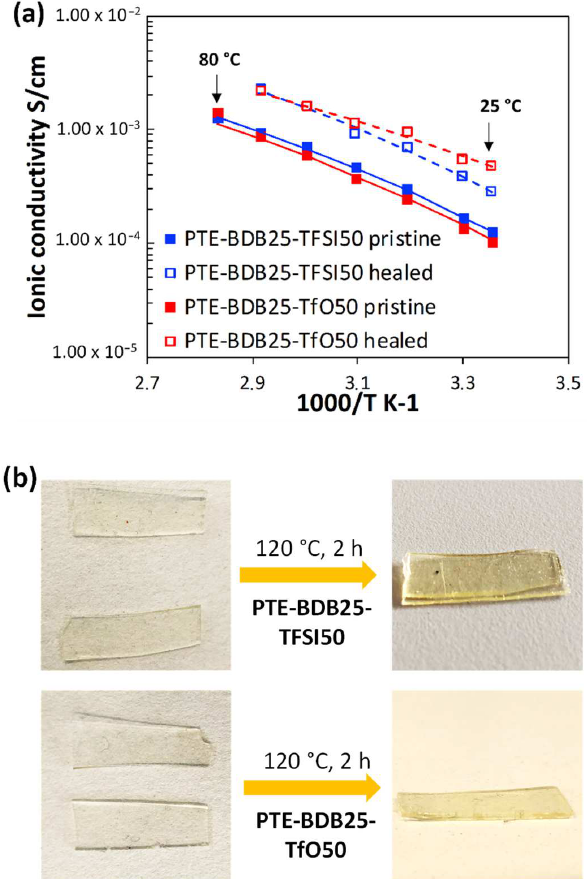
Figure 7. ( a ) Ionic conducting behaviors of PTE-BDB25-TFSI50 and PTE-BDB25-TfO50 samples at different temperatures before and after the healing test at 120 °C for 2 h; ( b ) Pictures of PTE-BDB25- TFSI50 and PTE-BDB25-TfO50 samples before and after healing.